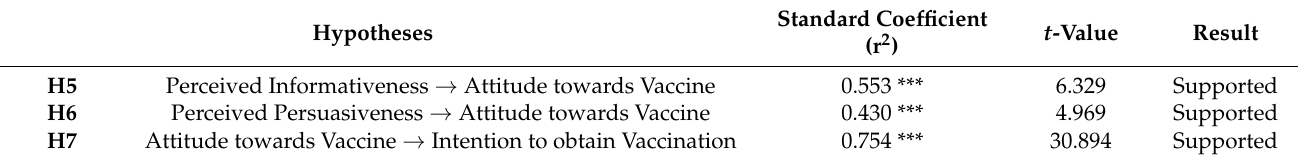
Table 4. Path analysis of H5–H7.